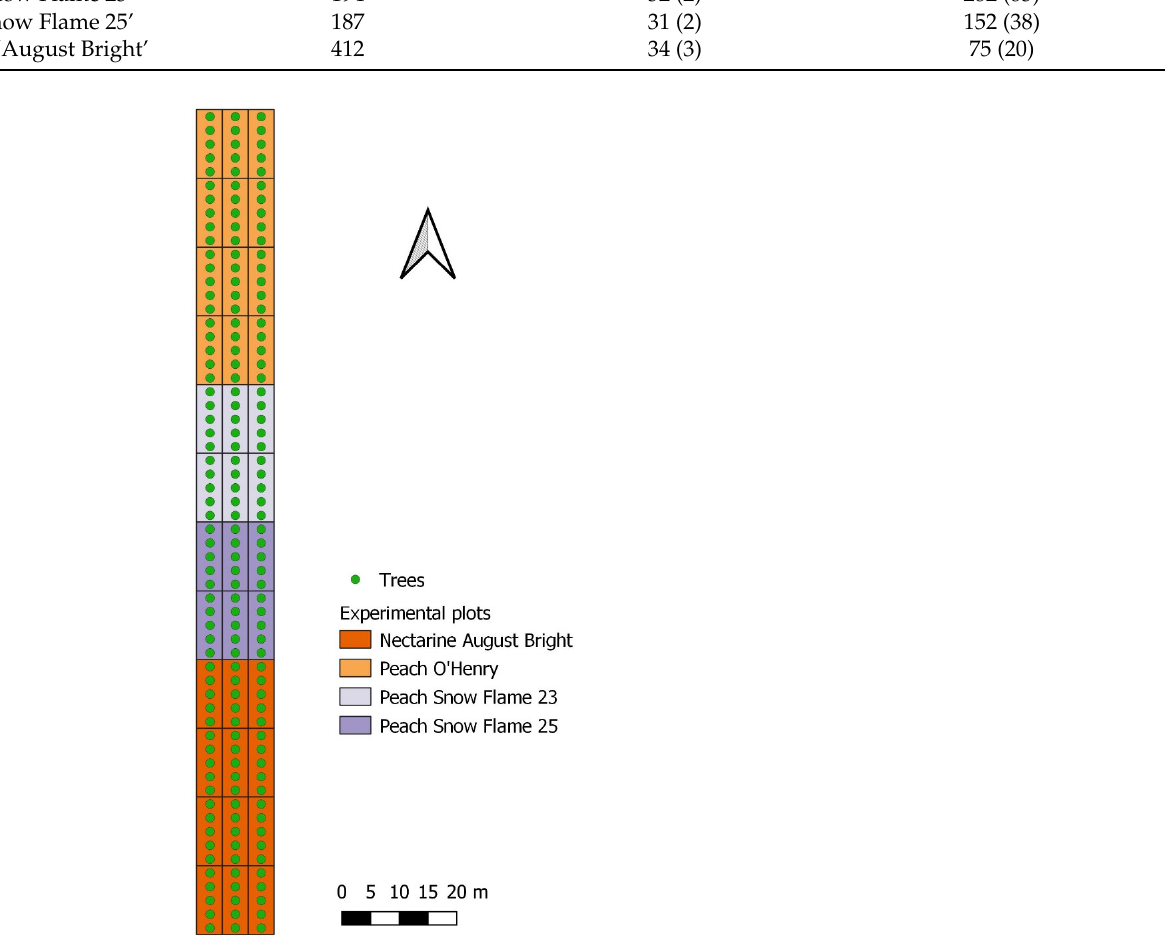
Figure 3. Spatial map of ‘O’Henry’ (60 trees), ‘Snow Flame 23’ (30 trees), ‘Snow Flame 25’ (30 trees) and ‘August Bright’ (60 trees) experimental plots and tree position in the Stonefruit experimental orchard at the Tatura SmartFarm. Table 1. Number of images and fruit detections from which the Colour Development Index (CDI) was calculated in the experimental plots shown in Figure 3. Standard deviations reported in brackets.